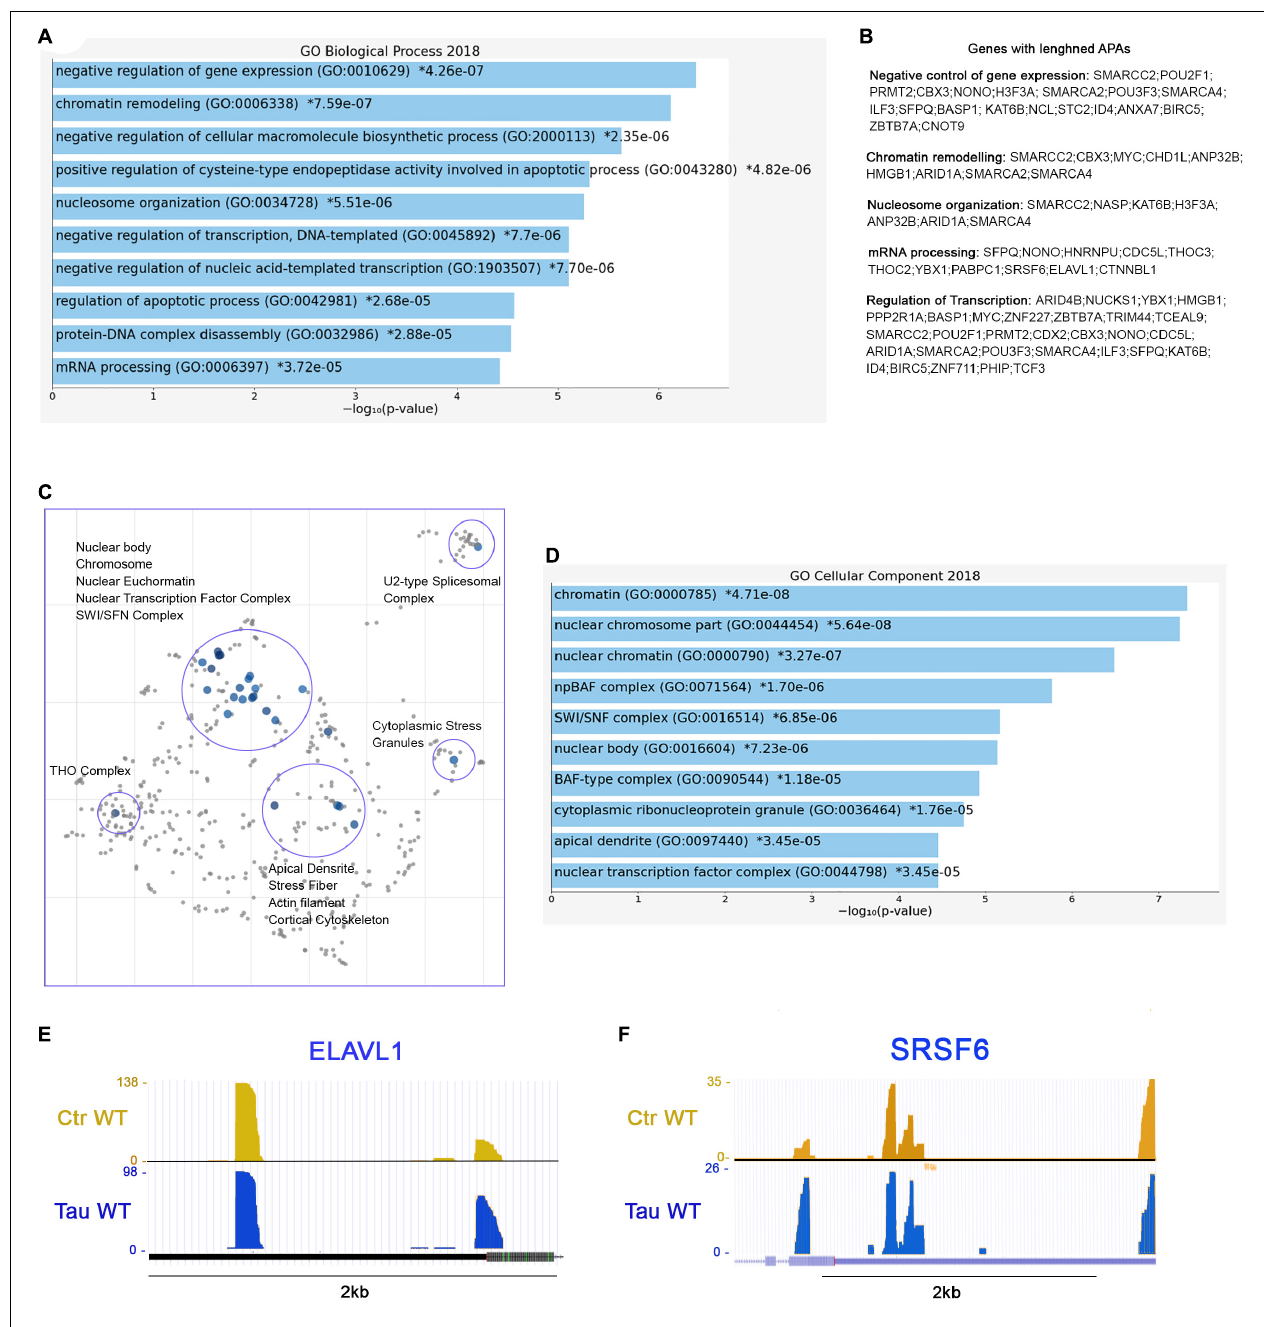
FIGURE 6 | RNA processing and splicing precursor’s display lengthened APAs in presence of WT tau. (A) Enrich-GO Biological Process of WT tau lengthened APAs ( p -value reported). (B) Partial list of biological process genes with lengthened APAs upon presence of WT tau negative control of gene expression, chromatin remodeling, nucleosome organization, mRNA processing and regulation of transcription). (C) The Cellular Components scatterplot of lengthened APAs in WT tau is organized so that similar gene sets are clustered together. The larger blue points represent significantly enriched terms—the darker the blue, the more significant the term and the smaller the p -value. The gray points are not significant. Plots has been generated and downloaded using scatter plot visualization Appyter. (D) Enrich-GO Cellular Component of WT tau lengthened APAs ( p -value reported). Representative poly-A site usage for lengthened poly-A tails from PAC-Seq of ELAVL (E) and SRSF6 (F) transcripts. An asterisk (*) next to a p -value indicates the term also has a significant adjusted p -value ( <